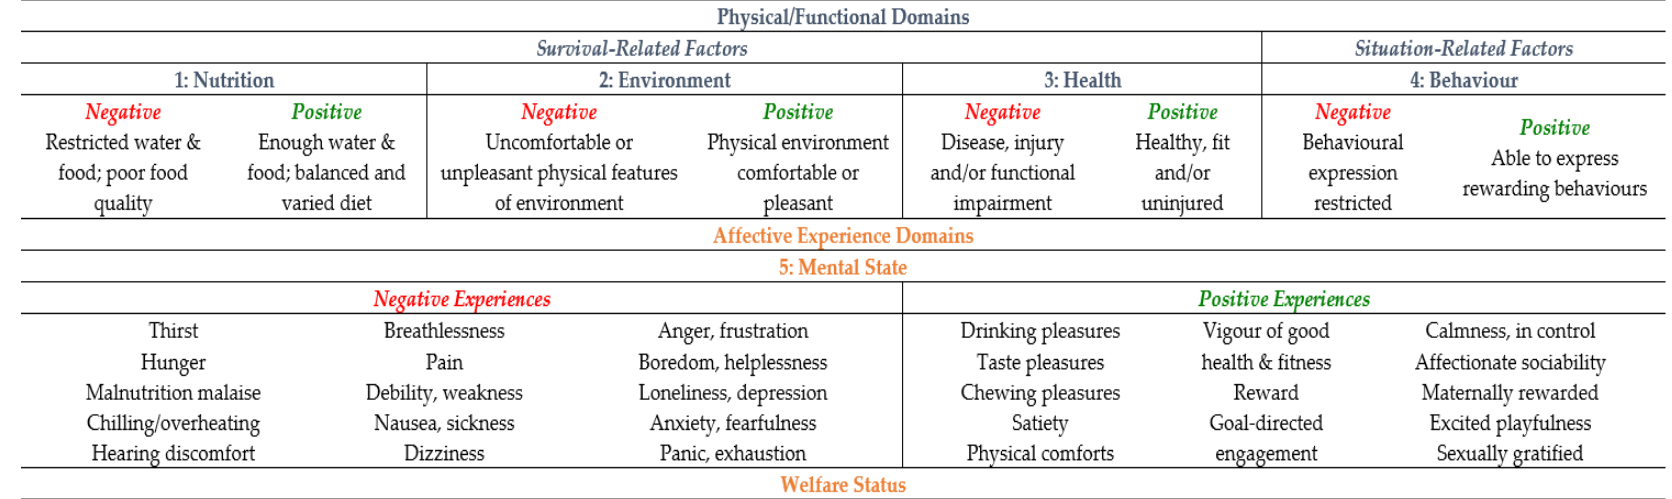
Figure 1. An abbreviated version of the Five Domains Model. It summarises survival-related and situation-related factors and their associated physical/functional domains, and provides examples of negative or positive affects assigned to the mental domain. The overall affective experience in the mental domain equates to the welfare status of the animals. For full details see [37].